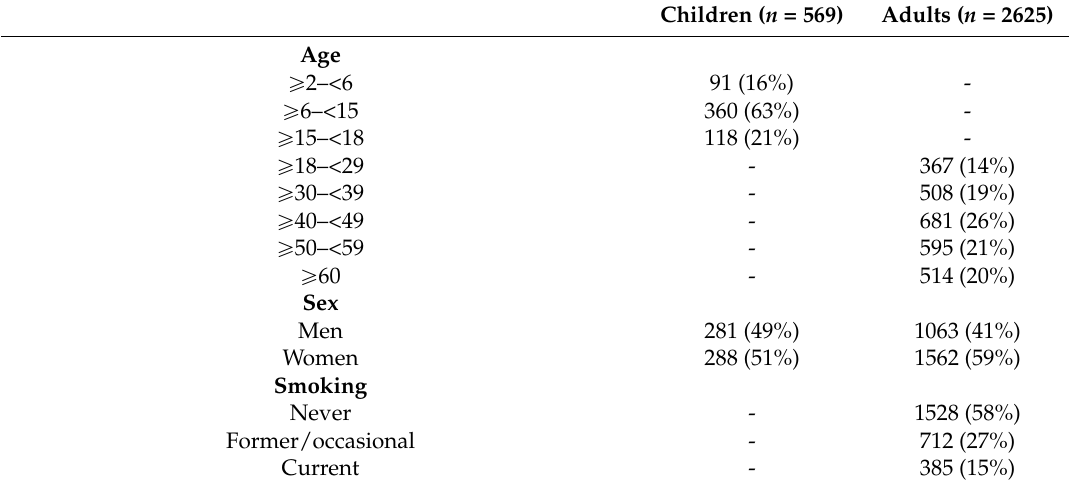
Table 1. Distribution of selected variables among StatusD participants a